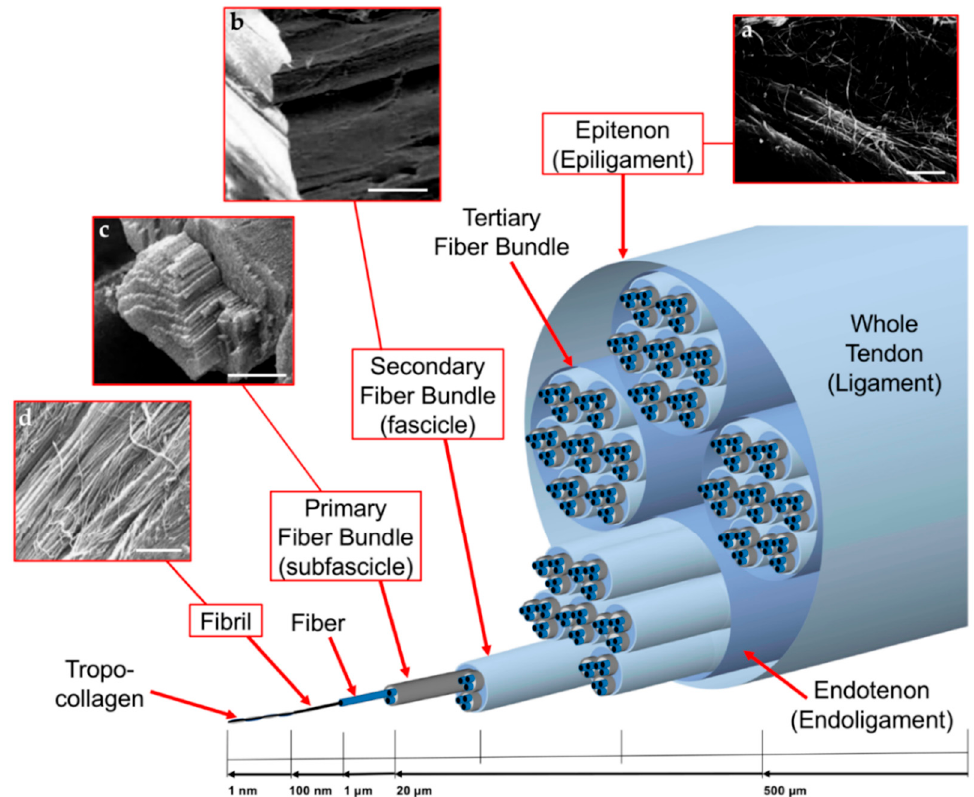
Figure 1. Hierarchical arrangement of the collagen of tendons and ligaments: ( a ) Scanning electron microscopy (SEM) of epitenon collagen fibrils (scale bar = 2 micrometers, adapted from Kannus et al. [6], reproduced with permission. Copyright 2008, John Wiley and Sons.); ( b ) SEM image of a collagen fascicle (scale bar = 100 micrometers); ( c ) SEM image of a collagen bundle (scale bar = 45 micrometers); and ( d ) SEM image of collagen fibrils (scale bar = 1.8 micrometers). ( b – d ) SEM images adapted from Moshiri et al. [17], reproduced with permission under the terms of the CC BY 4.0 license. Copyright 2013, OMICS Publishing Group.